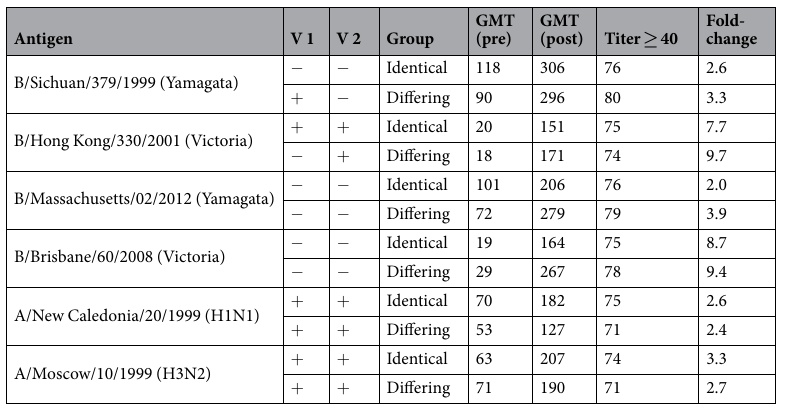
Table 4. HI Data for B Experimental Cohort vaccinated in 2001–2003. The names of the antigens used in the HI assay are listed in the first column. In the second and third columns + and − are used to indicate if the antigen was used in the first (V1) or second (V2) vaccination. The geometric mean titers prior to vaccination (pre) and after both vaccinations (post) are shown for each antigen for each group (Identical or Differing). The number of titers ≥ 40 is shown as a percentage. The fold-change is the average increase between the pre- and post-vaccination